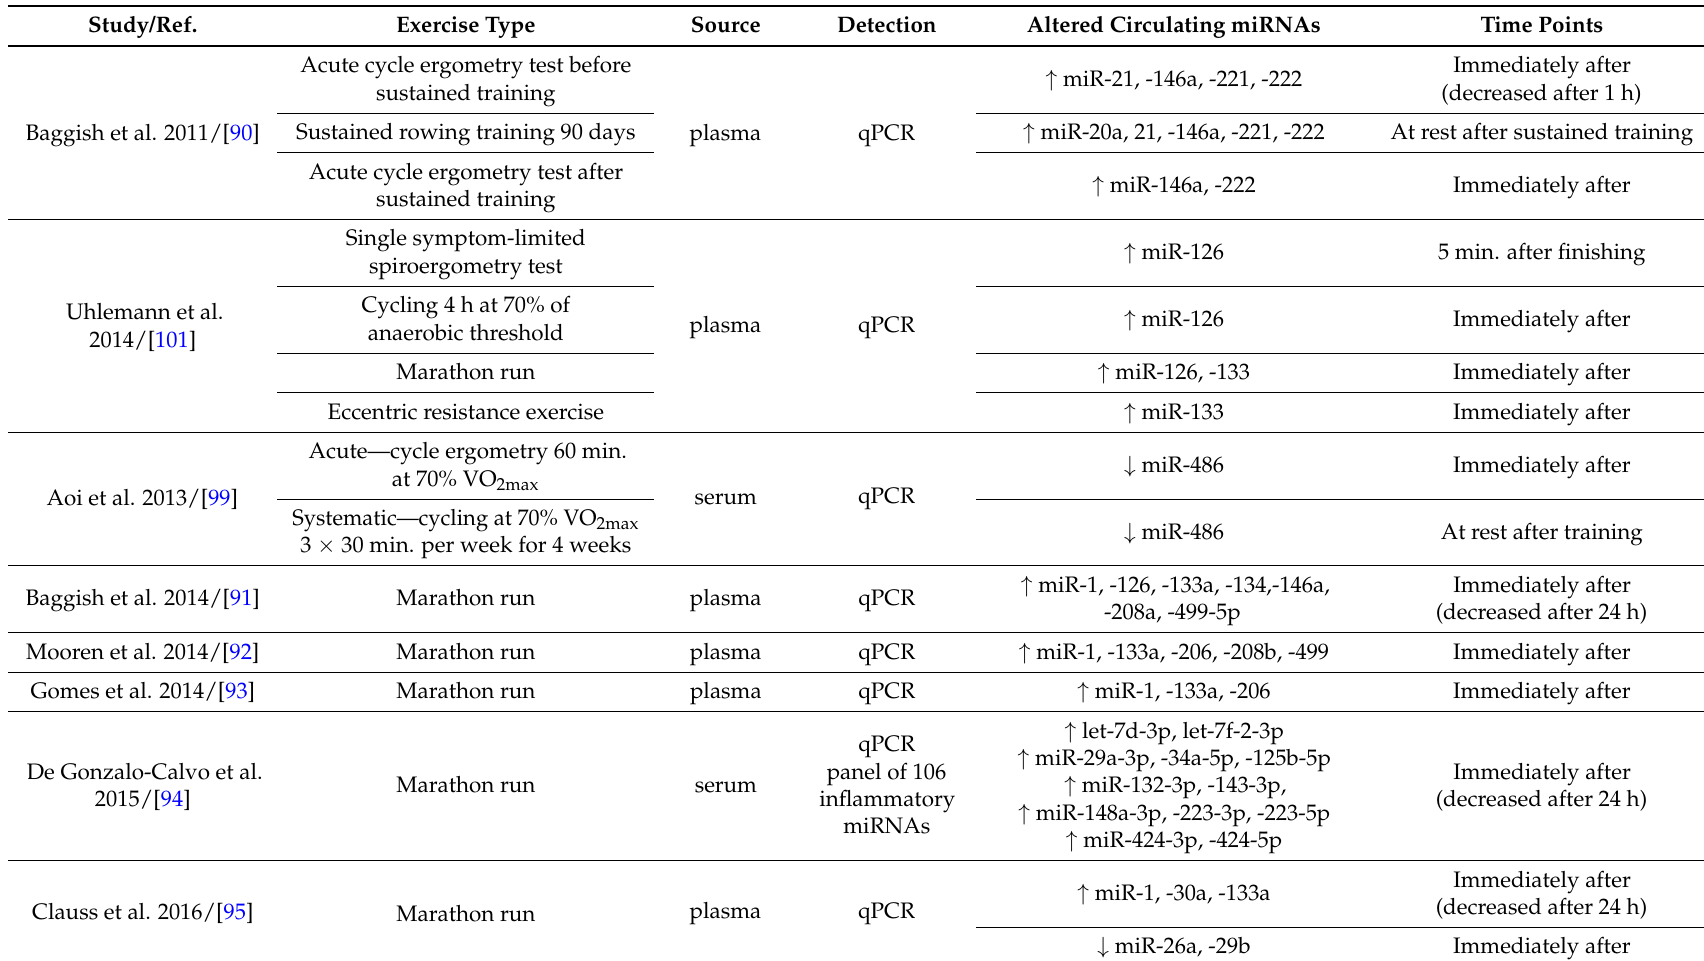
Table 1. Circulating microRNAs (c-miRNA) plasma or serum profiles altered by various types of exercise in overviewed studies.